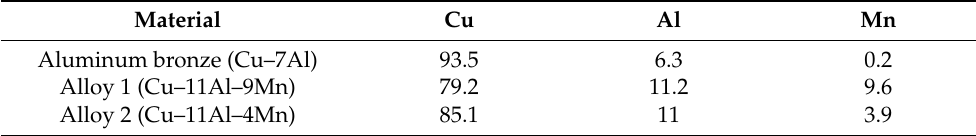
Table 1. Chemical composition of raw materials